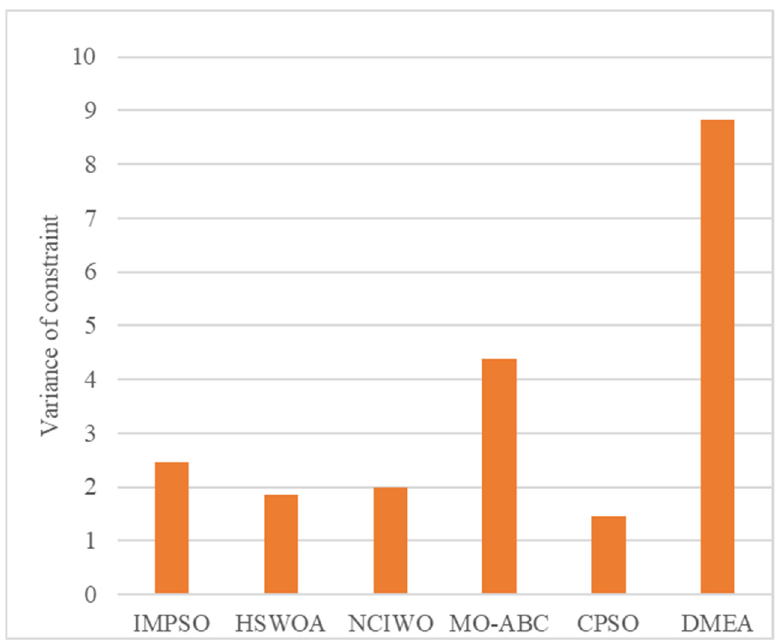
Figure 4. Comparison results among average values of HSWOA, NCIWO, MO-ABC, CPSO, DEMA and IMPSO in Tm variance.